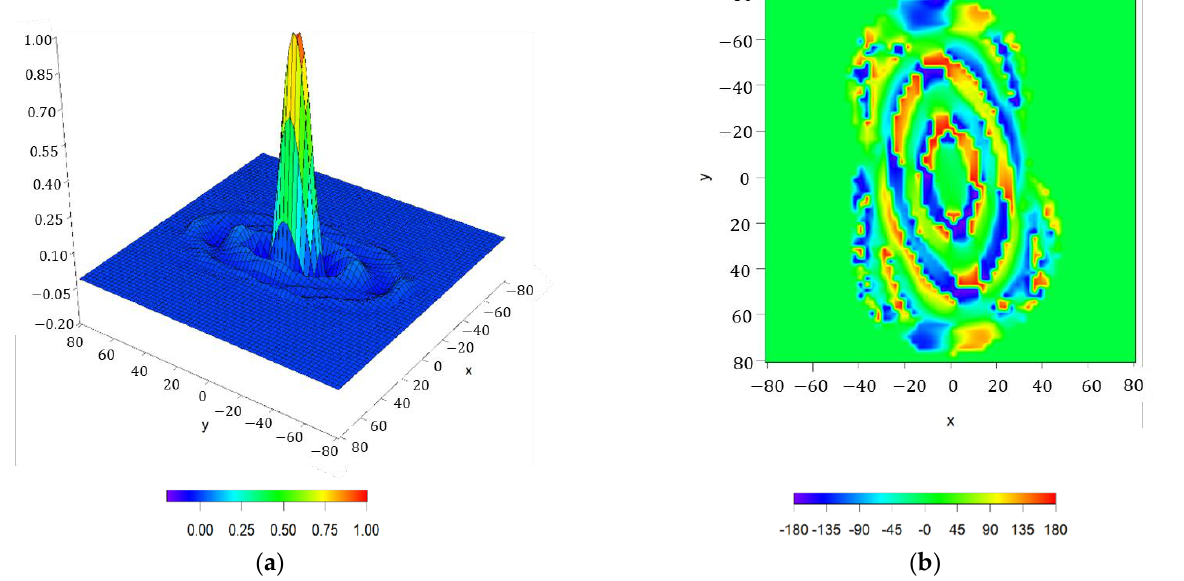
Figure 18. Discretized array antenna which generates the pattern of Figure 16: ( a ) normalized current distribution of the array antenna in the presence of subarrays of 5 × 5 elements. ( b ) Phases (°) of the antenna excitation currents.